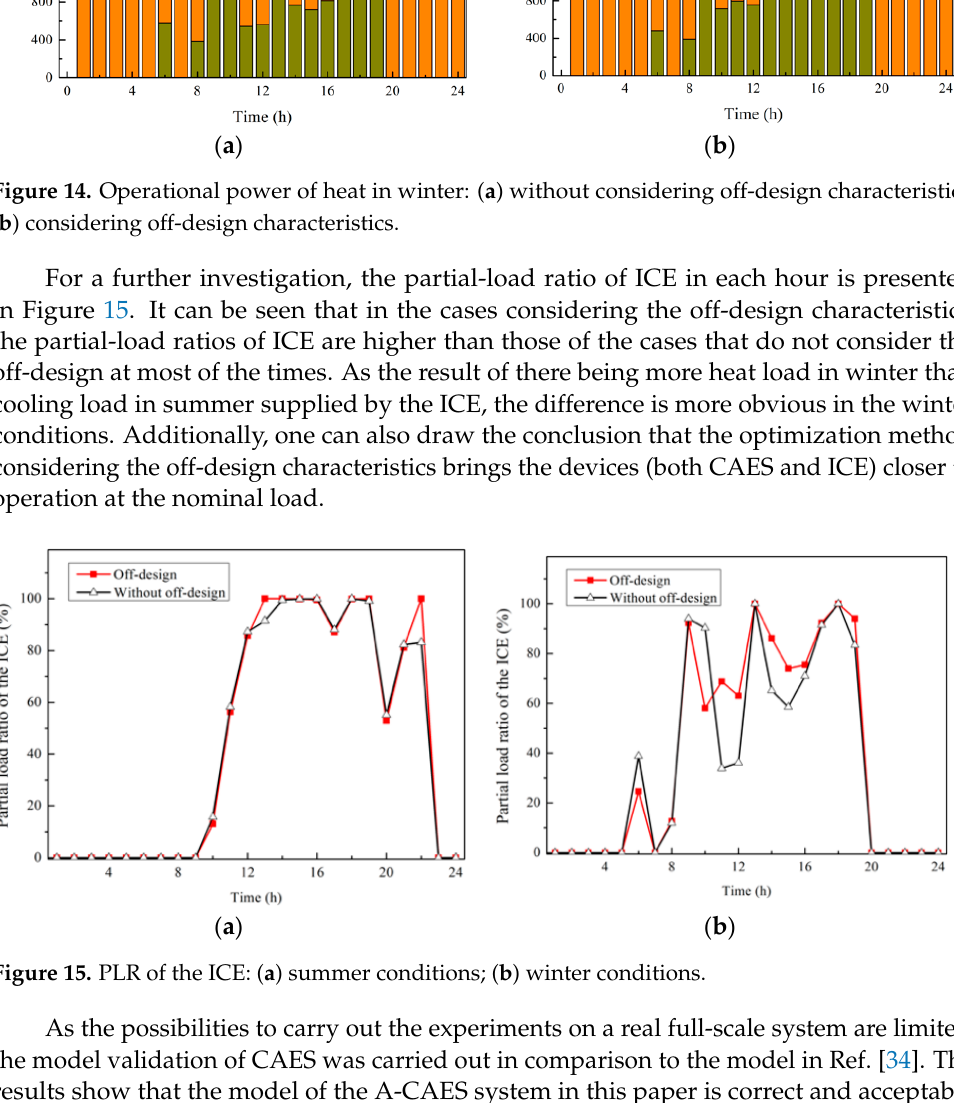
Table 6. The comparison of the A-CAES model results from the present model and Ref. [34].